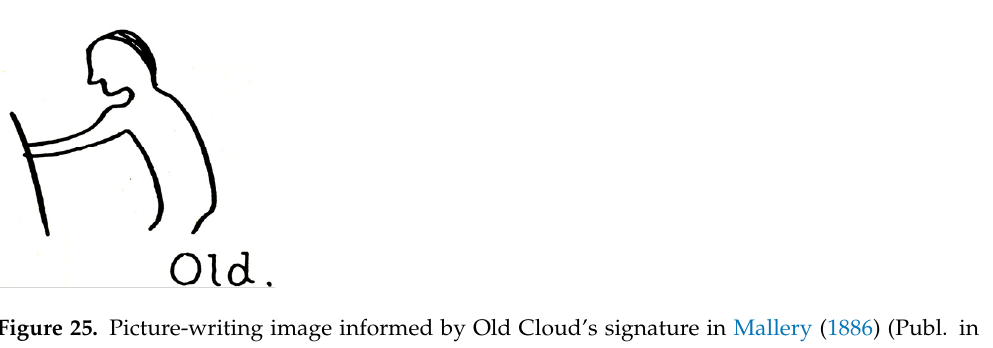
Figure 24. Picture-writing image for “old” reimagined by Tomkins for his Boy Scout monograph (Publ. in Tomkins 1926).